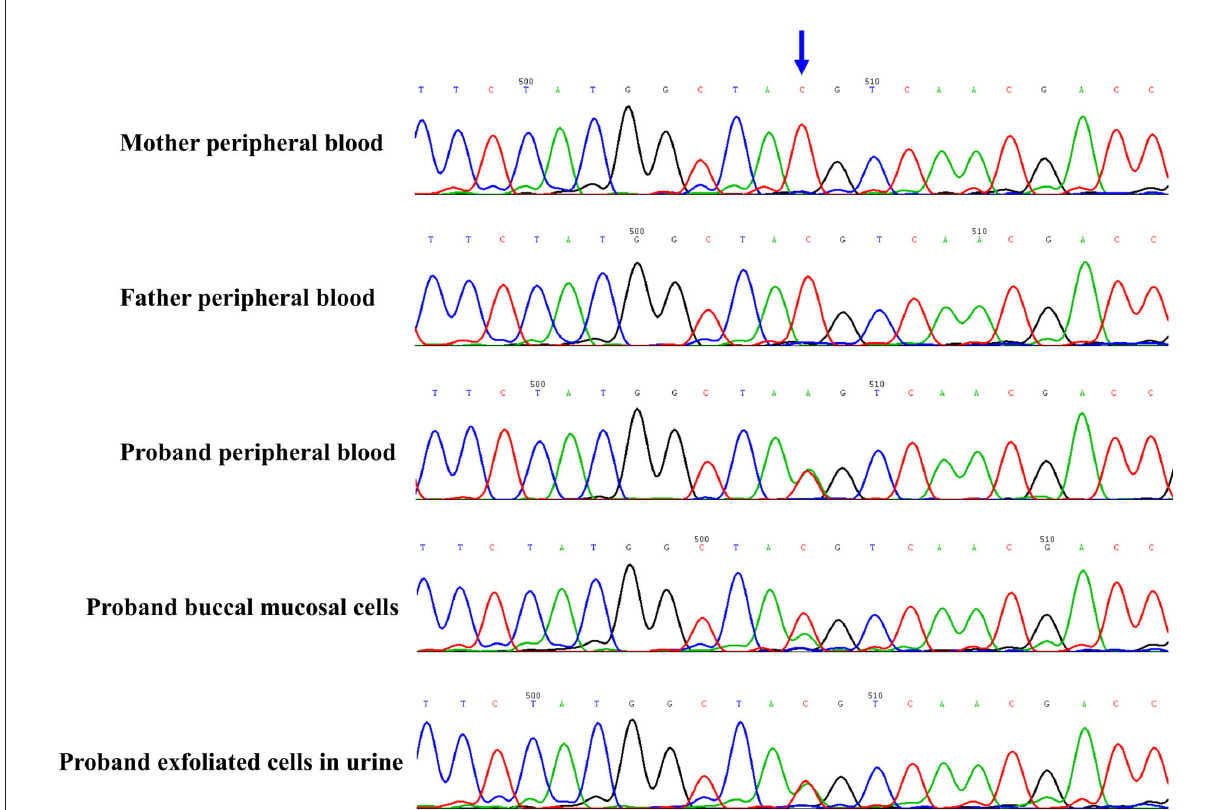
FIGURE2 The novel de novo mosaic mutation in PCDH19 gene in proband confirmed by Sanger sequence. The variant was identified in proband but absent in parents. The proportion of mosaic mutation (c.840C > A, p. Tyr280*) in PCDH19 gene was 27.9% in, buccal mucosal cells, 48.3% in exfoliated cells in urine and 42.4% in peripheral blood of